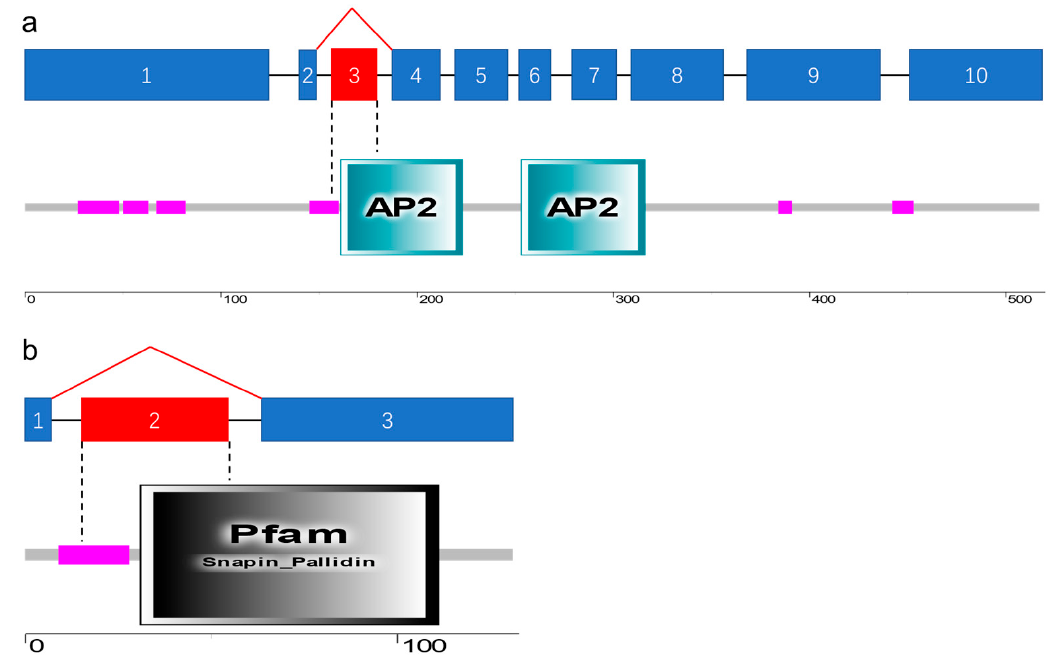
Figure 4. Alternative splicing-induced protein domain analysis: ( a ) alternative splicing caused the AP2 domain to change in AP2/ERF; ( b ) alternative splicing caused the loss of the Snapin/Pallidin domain in SNARE. The skipped exons are marked in red.